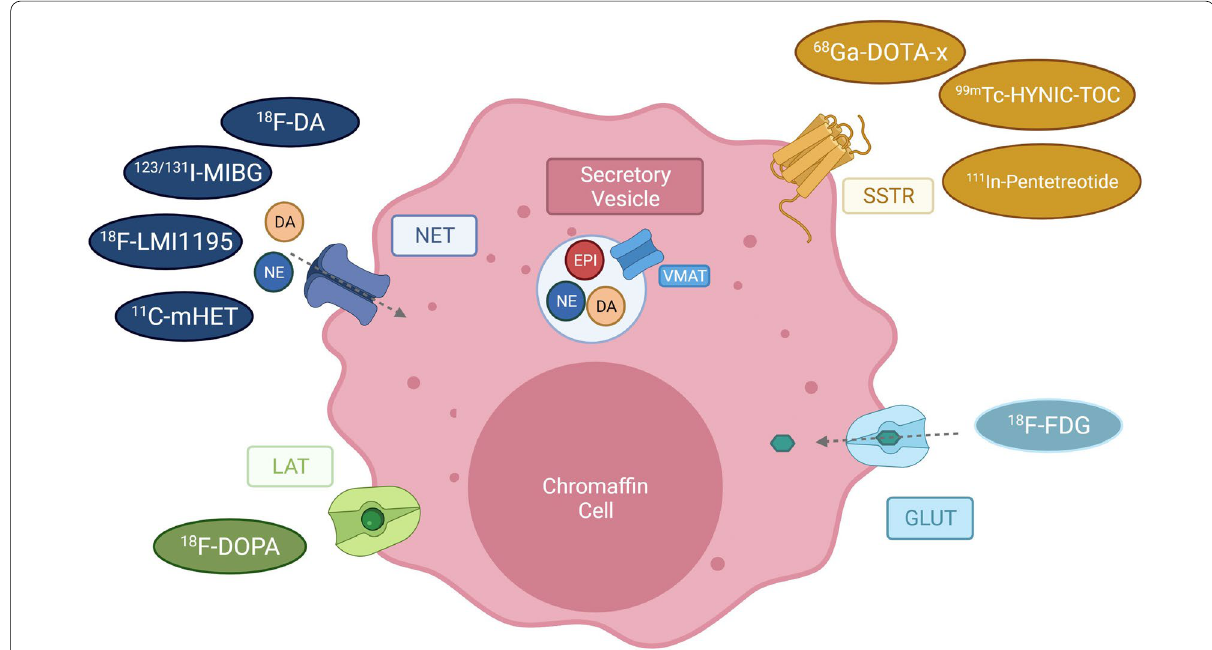
Fig. 1 Available PET tracers for imaging of pheochromocytoma and paraganglioma. Depicted are receptors of chromaffin cells used as targets for PET imaging ( LAT large amino acid transporter, NET Norepinephrine transporter, SSTR Somatostatin receptor, GLUT glucose transporter) and = their tracers ([ 18 F]-DOPA [ 18 F]-dihydroxyphenylalanine; [ 68 Ga]-DOTA-X derivatives of [ 68 Ga]1,4,7,10-tetraazacyclododecane-tetraacetic acid, e.g., = = DOTATATE, DOTA-NOC, DOTA-TOC, [ 99m Tc] -HYNIC-TOC [ 99m Tc]-hydrazinonicotinyl-Tyr3-octreotide, [ 18 F]-FDG , [ 18 F]-Fluordesoxyglucose). The = = vesicular monoamine transporter (VMAT) transports catecholamines as norepinephrine (NE), epinephrine (EPI) and dopamine (DA) into secretory vesicles, from where they are released into the extracellular matrix. Reuptake or norepinephrine is mediated via the NET transporter. ( Adapted from Blanchet et al., 2011